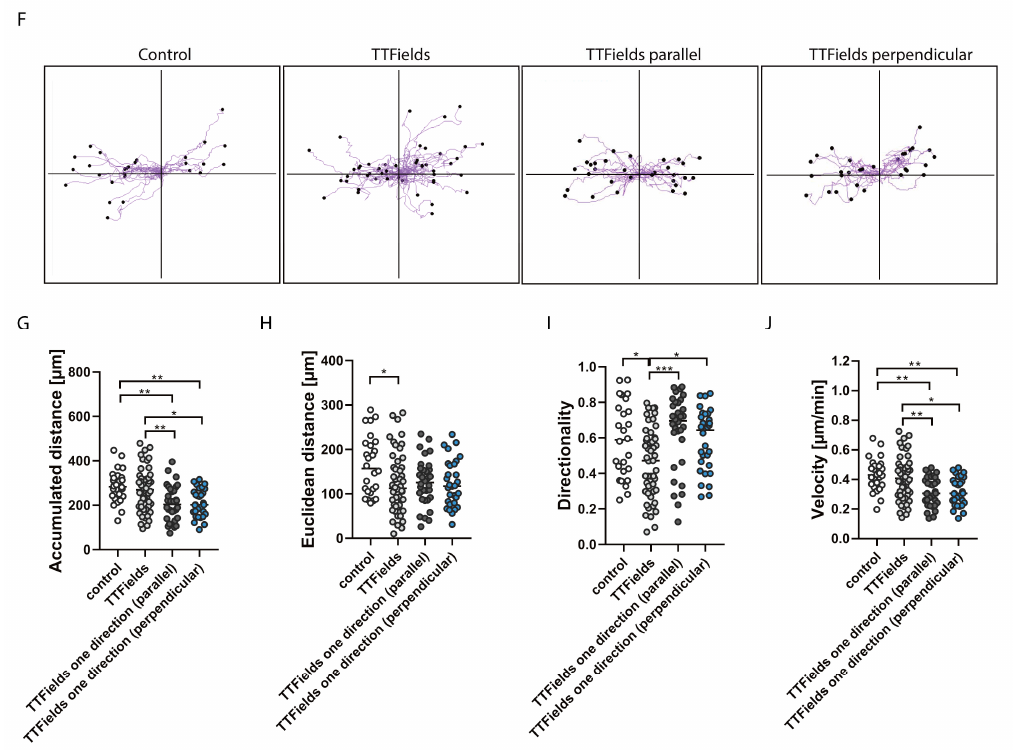
Figure 2. TTFields exposure hinders cancer cell migration ( A , B ). A cell-free gap was created in cancer cell monolayers for U-87 MG and A-172 cells ( A , B ). Baseline images of the cell-free gap at 0 h and cells that migrated into the cell-free area 14 h later, at the same reference points, are shown for each GBM cell line (A-B left panels). Quantitative analysis of migration rates (velocity) for each GBM cell line are depicted (A-B right panels). Mean + SEM; paired t -test. ( C ) Uni-directional application of TTFields cell system set-up is illustrated. ( D ) A cell-free gap was created in A-172 cancer cell monolayer (as in A-B). TTFields were applied uni-directionally using one set of transducer arrays. ( E ) Quantitative analysis of average migration velocity. Mean + SEM; one-way ANOVA, followed by Tukey’s pos t -test. ns, not significant. ( F , J ) Migratory tracks of single cells exposed to TTFields. ( F ) Right and left tracks indicate, respectively, right and left motion toward the cell-free gap. At least 10 cells from each movie were traced. Bar diagrams for cellular measures of ( G ) accumulated distance, ( H ) Euclidean distance (length of the straight line from start to the endpoint), ( I ) directionality or directional persistence, and ( J ) velocity. Mean; one-way ANOVA, followed by Tukey’s pos t -test. * p < 0.05, ** p < 0.01, and *** p <